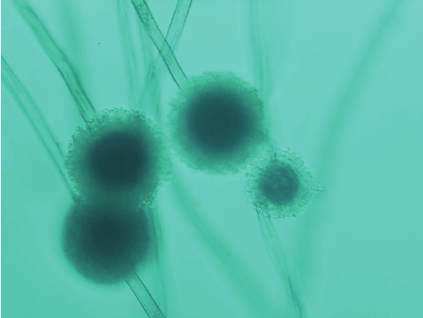
Figure 4: Conidial heads and brownish roughened conidiophores of Aspergillus ochraceus (Lactophenol Aniline Blue preparation).